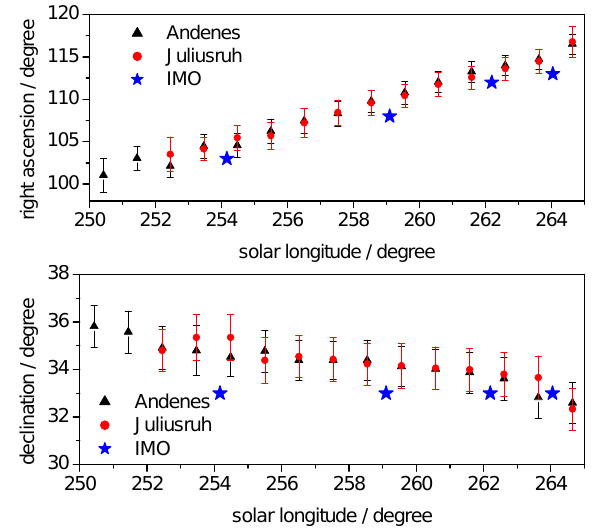
Fig. 4. Geminid radiant position for the Juliusruh and Andenes me- teor radars for different solar